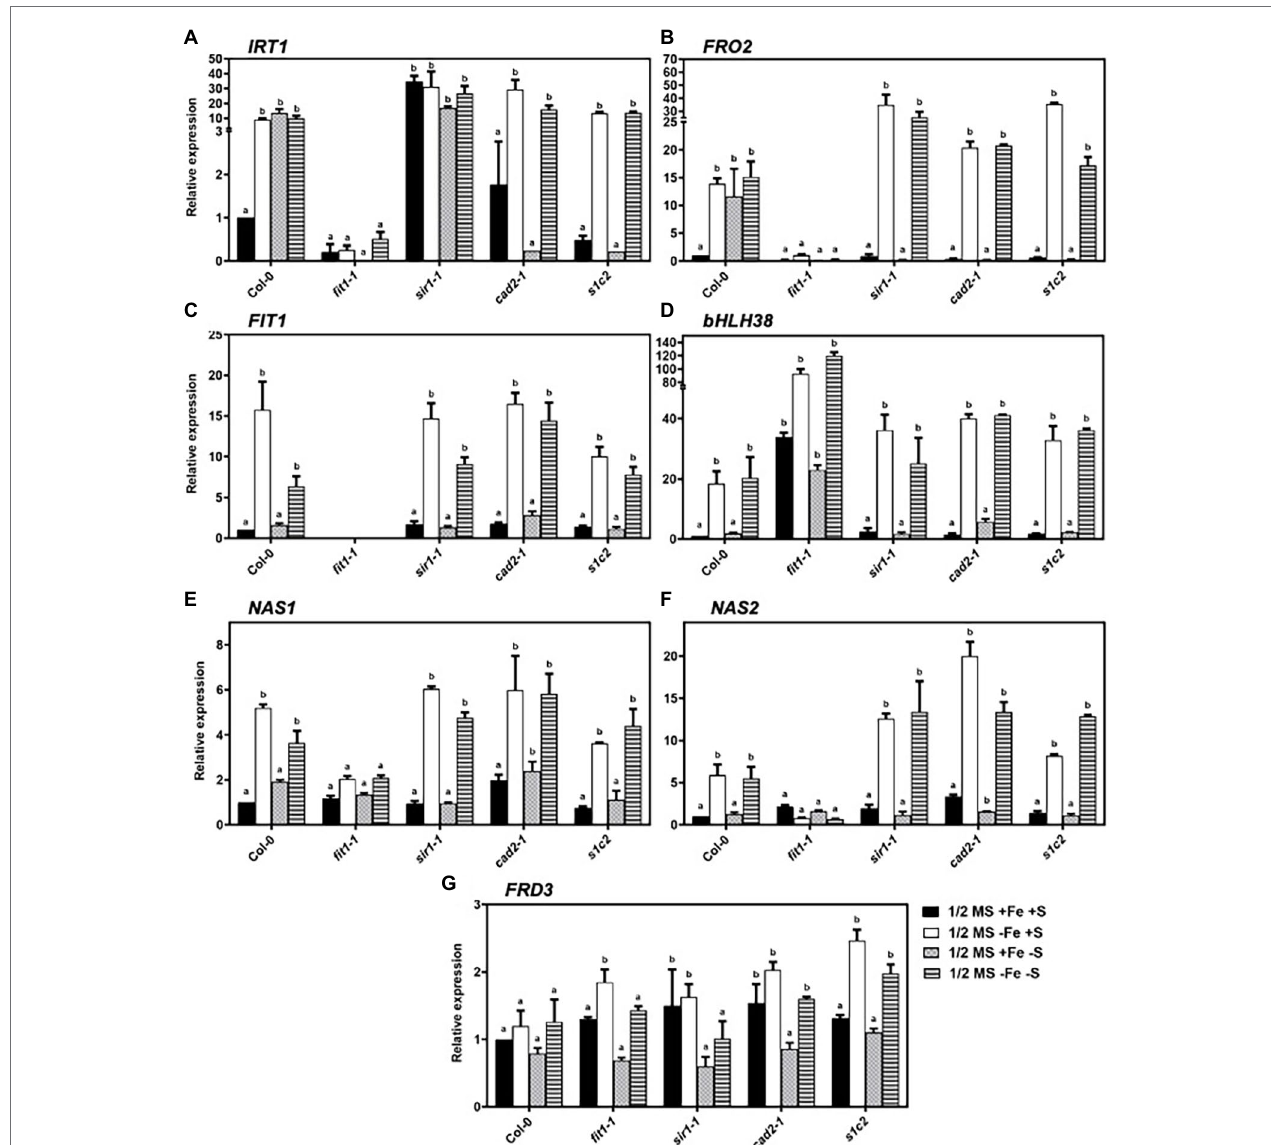
FIGURE 2 | Expression profiles of the genes related to iron-homeostasis in Arabidopsis roots. Relative expression by quantitative RT-PCR of IRT1 (A) , FRO2 (B) , FIT (C) , bHLH38 (D) , NAS1 (E) , NAS2 (F) , and FRD3 (G) in the roots of Arabidopsis wild type (Col-0), fit1-2 , sir1-1 , cad2-1 , and s1c2 lines of 1-week old seedlings exposed to half-strength MS medium (1/2 MS + Fe + S), Fe-deficient (1/2 MS − Fe + S), S-deficient (1/2 MS + Fe − S), and Fe and S-deficient (1/2 MS − Fe − S) media for 4 days under long-day conditions. The y -axis shows RNA levels normalized to that of GADPH . (A–G) Letters indicate the statistically significant differences between the wild type (Col-0) on ½ MS + Fe + S with the other treatments in Col-0 and mutants, determined with the two-way ANOVA test followed by Dunnett’s test ( p < 0.05, n = 3). Bars represent means ±